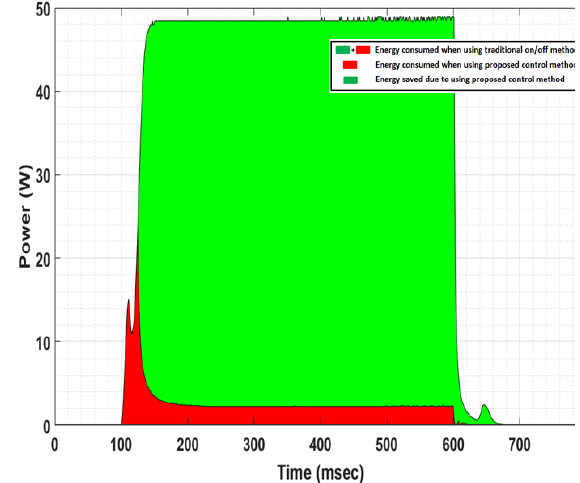
Figure 156. Power consumed energy and saved energy of the solenoid valve when it is energized by the traditional on/off method and the proposed control method.